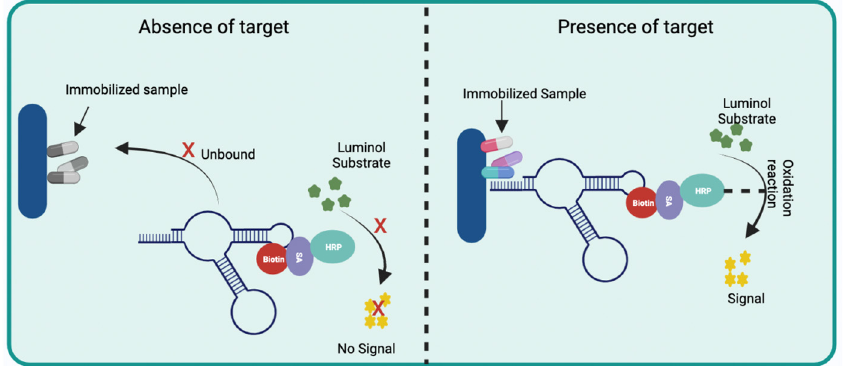
Figure 5. Schematic representation showing the operation of a chemiluminescent aptasensor. This aptasensor consists of an immobilized sample, which does not interact with the biotin-labeled aptamer when the target is not presented. Streptavidin (SA) conjugated with horseradish peroxidase (HRP) is discarded after washing; therefore, in the presence of luminol, an oxidation reaction does not occur, avoiding a chemiluminescent signal. On the other hand, when the target is presented, the biotin-tagged aptamer is immobilized, which then interacts with the HRP-conjugated SA, releasing a chemiluminescent signal in the presence of its substrate. Created with BioRender.com.